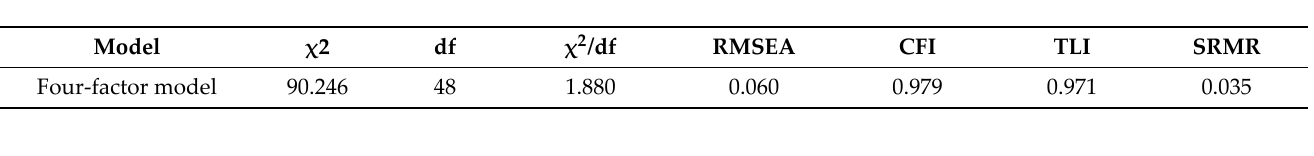
Table 4. Model Fitness Index Shown in CFA.